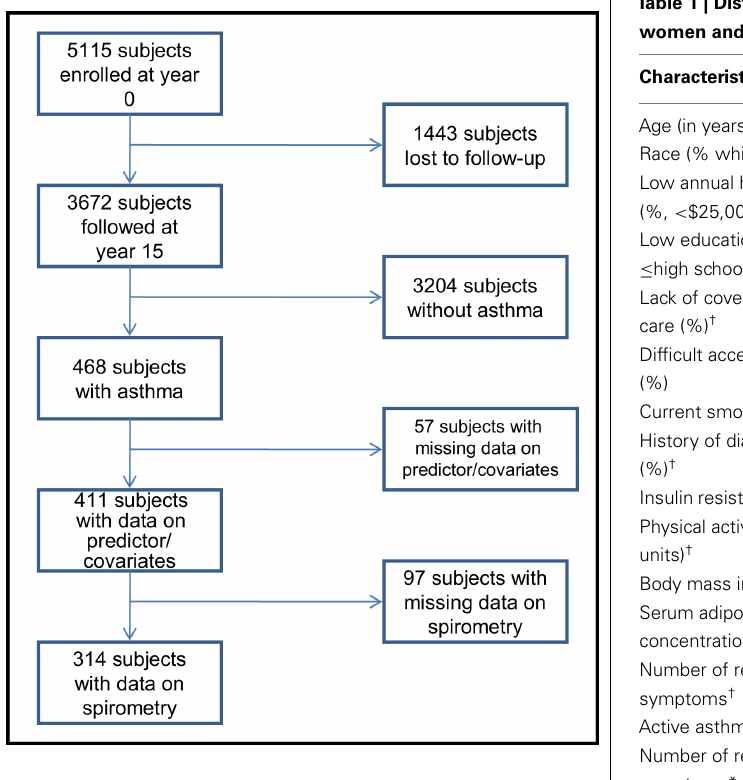
FIGURE 3 | Flowchart of subject